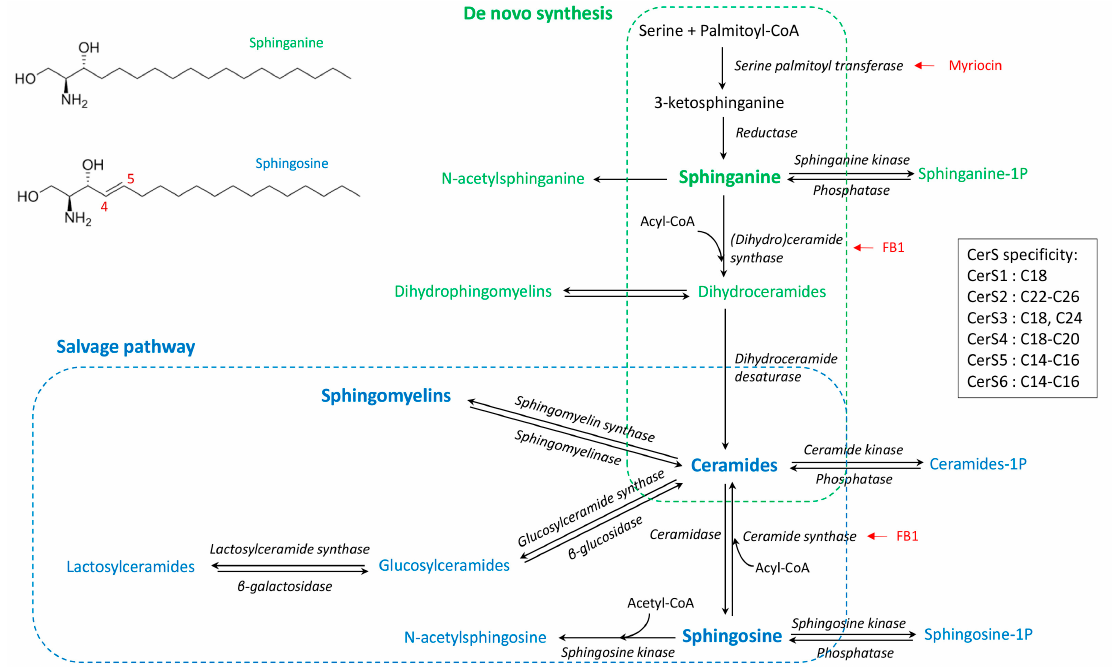
Figure 1. Simplified synthesis scheme of sphingolipids according to the de novo and salvage path- ways, and the fatty acid chain length specificity of ceramide synthases (CerS). Dihydrosphingolipids formed with sphinganine are in green whereas sphingolipids formed with sphingosine are in blue. Known enzyme inhibitors of ceramides synthesis are in red [15].